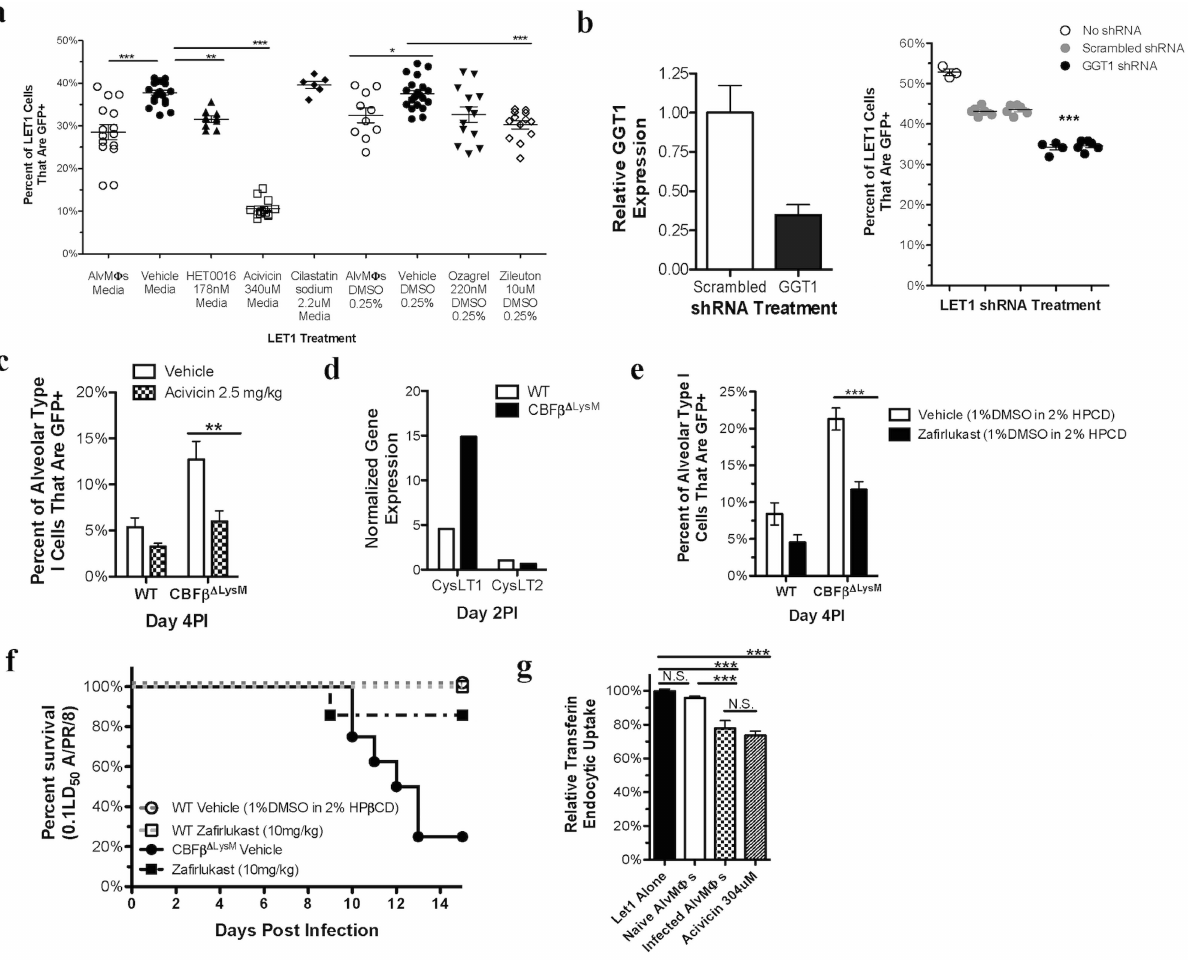
Fig 6. Inhibition of the 5-LOX pathway or blockade CysLT1 renders T1AECs resistant to IAV infection. a) Infectivity of LET1 cells infected with NS1-GFP A/PR/8 in the presenceof the specifiedtreatment. b) Lentivirus shRNA knockdown of GGT1 (left panel)and the impact LET1 cell infectivity (right). c) WT and CBF β Δ LysM mice were infected i.n. with NS1-GFP A/PR/8 and treated i.n. with 2.5mg/kg of Acivicin or vehicleat 5 and 29hourspost infection. Infection of T1AECs (left) and conductingairway epithelialcells (right) was analyzedat day 4 PI. d) Expression of the CysLT1 and CysLT2 receptors in sorted T1AECs from WT and CBF β Δ LysM at day 2PI as determinedby RNAseq. e) Day 4 T1AEC infectivity in WT and CBF β Δ LysM mice that were infected i.n. with NS1-GFP A/PR/8 and. f) CBF β Δ LysM mice that were infected i.n. with 0.1LD 50 of A/PR/8 and treated i.p. with 10mg/kg of Zafirlukast or vehicle every 24 hours starting at 5 hours PI until day 3 PI. g) Relativefluorescence of pHrodoRed labeledtransferrin that has been taken up via the endocytic route by LET1 cells in the presence of different treatments. For in vitro analyses, data were pooledfrom, or is representative of, a minimum of 3 experiments with each dot representing2-pooledwells from a 24wellplate. c and e) data was pooled3 experiments for a total of 4–6 mice for each treatment and genotype.Error bars are standarderror mean. Statistical analysisis a either a 2-way ANOVA, 1-way ANOVA, or a two-tailednon-paired students t test. * indicatesP < .05, ** for P < .001 and *** for P <